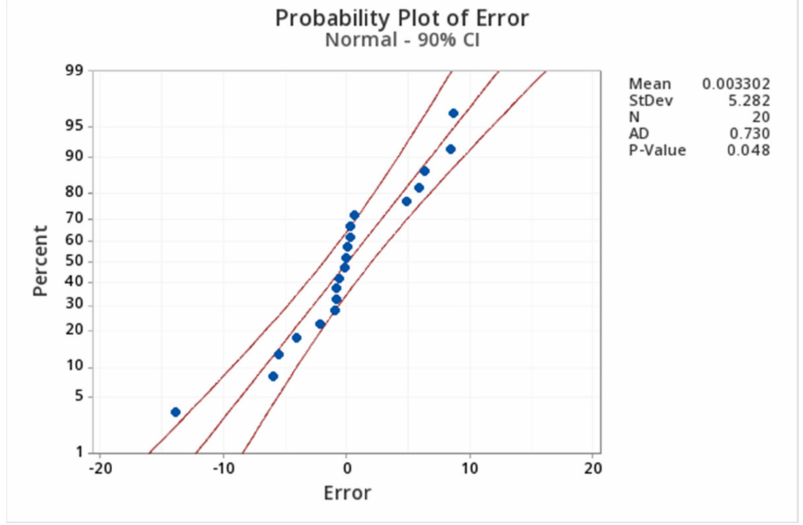
Figure A2. Normal probability plot of residuals for the effects on 1,2-PD selectivity. Part 2. Effect of Factors on Glycerol Conversion Table A3. ANOVA for single factor effects on glycerol conversion analysis.